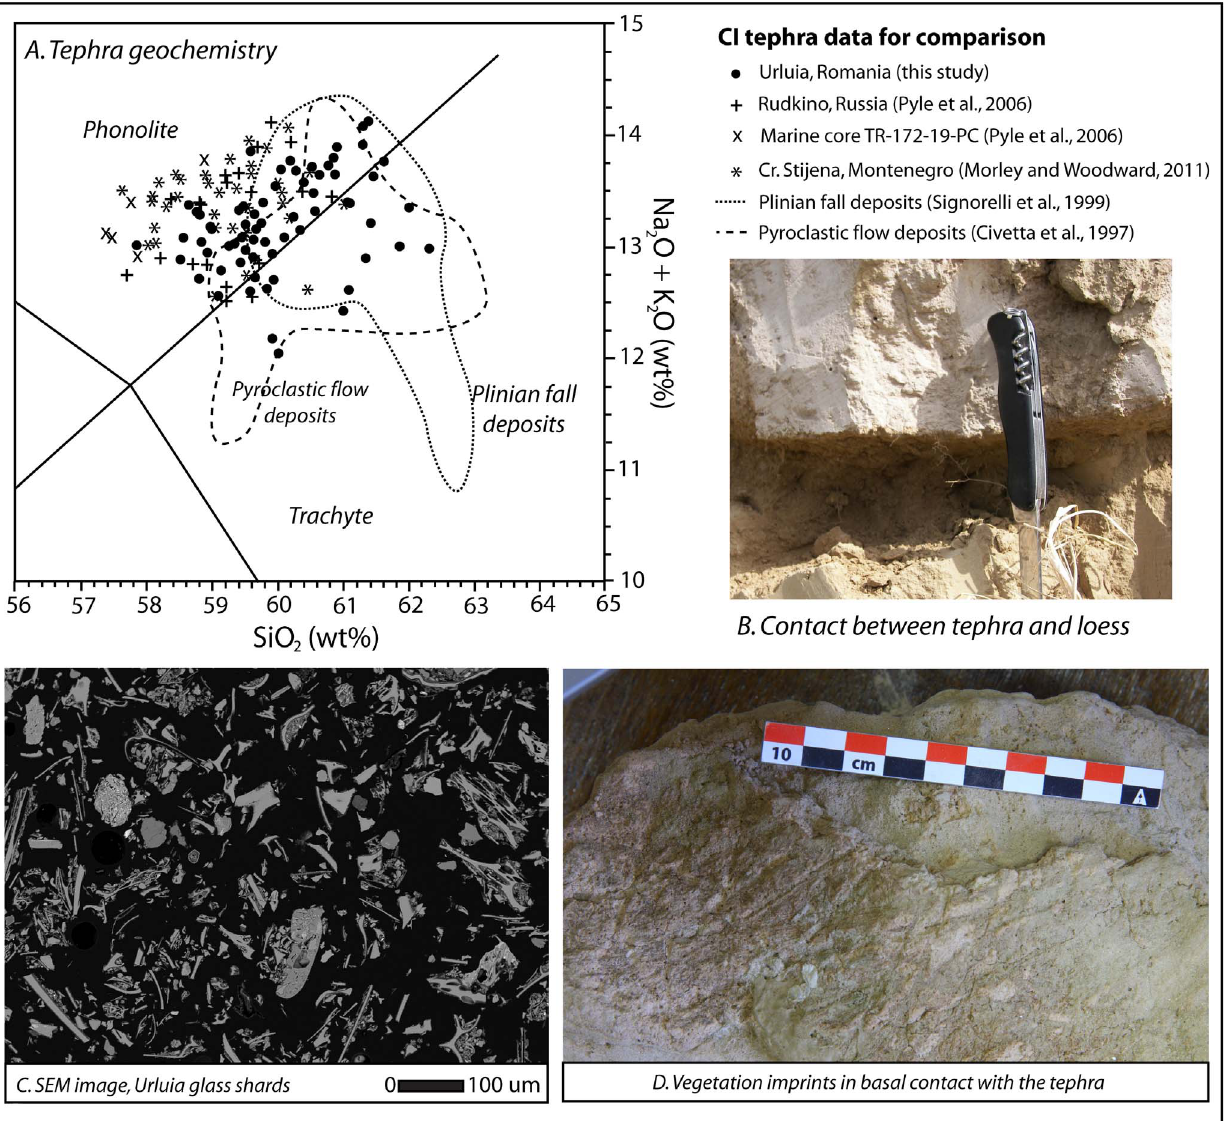
Figure 4. Characteristics of the tephra at Urluia. a. Geochemical profile of the Urluia tephra compared with CI data from Italy, eastern Europe and Mediterranean Sea cores [4,8,53,66]. b. Photograph of the contact between the tephra and underlying loess deposits. c. Photomicrograph from scanning electron microscope (SEM) of tephra shards. d. Vegetation imprints at the basal contact of the tephra with the loess (looking upward), collected from the exposure at